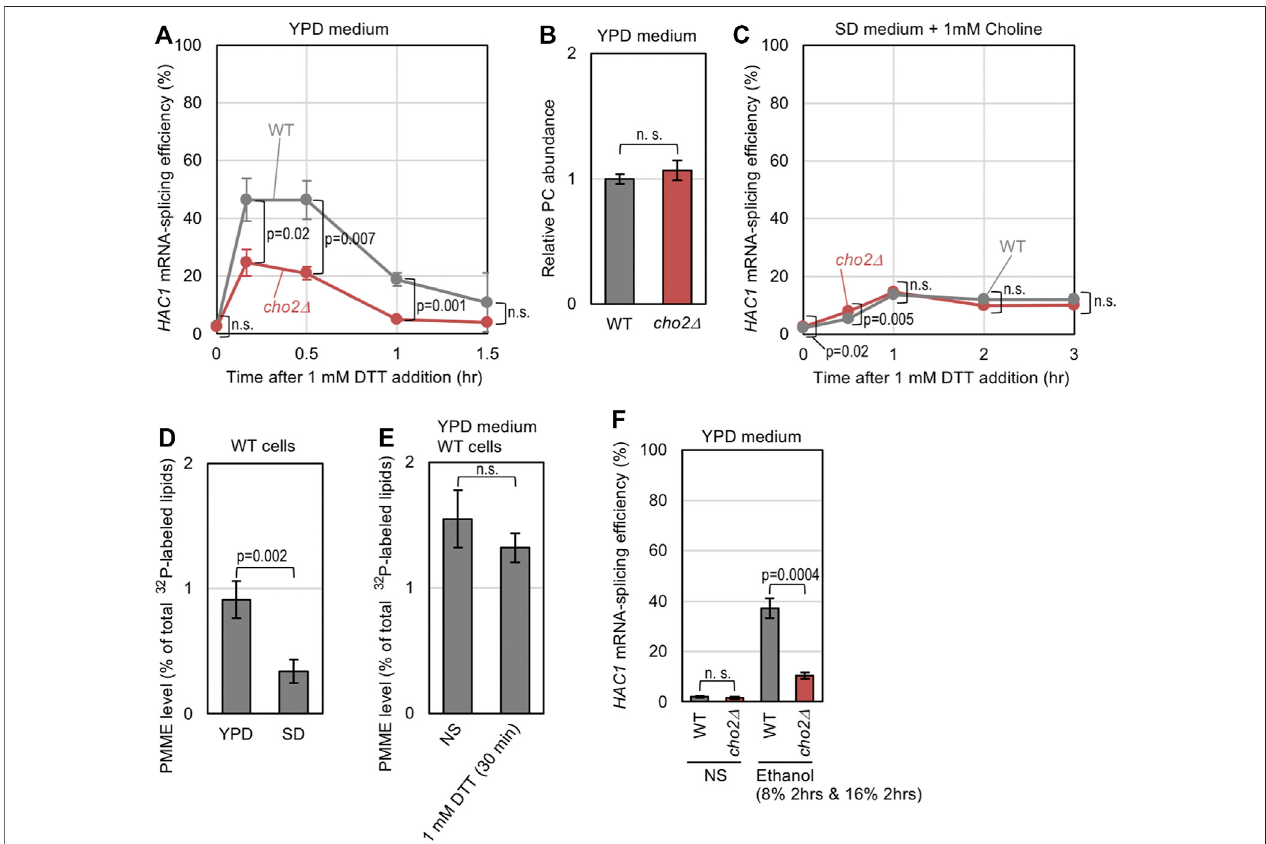
FIGURE5| PossibleinvolvementofendogenouslyaccumulatedPMMEintheUPRlevelofyeastcells. (A) Wild-type(WT)yeaststrainBY4741andits cho2 Δ mutant weregrowninYPDmedium,intowhich1 mMDTTwasaddedbeforefurtherculturingfortheindicateddurations.Thecellswerethencheckedfor HAC1 -mRNAsplicing. (B) BY4741(WT)and its cho2 Δ mutant weregrown inYPD medium. Afterharvesting, their lipidicextracts wereassayedfor PCabundance as described inthe Materials and Methods section. (C) The same experiment as shown in (A) was performed, except that SD medium containing 1 mM choline was used instead of YPD medium. (D) BY4741 cells (WT cells) were grown in YPD or SD medium containing 32 P-orthophosphate. After harvesting, their lipidic extracts were assayed for the PMME levels as shown in Supplementary Figure S1 . (E) BY4741 cells (WT cells) were grown in YPD medium containing 32 P-orthophosphate, into which 1 mM DTT was added (or not added (non-stress: NS)) before further culturing for 30 min. After harvesting, their lipidic extracts were assayed for PMME levels as shown in Supplementary Figure S1 . (F) BY4741 (WT) and its cho2 Δ mutant were grown in YPD medium, and were stressed by a two-step addition of ethanol into the medium (culturingwith8%ethanol for2 h followed bya2-h culture with ahigher concentration(16%) ofethanol)or remained non-stressed (NS).The cellswere then checked for HAC1 -mRNA splicing. ns, not signi fi cant ( p > 0.05%).